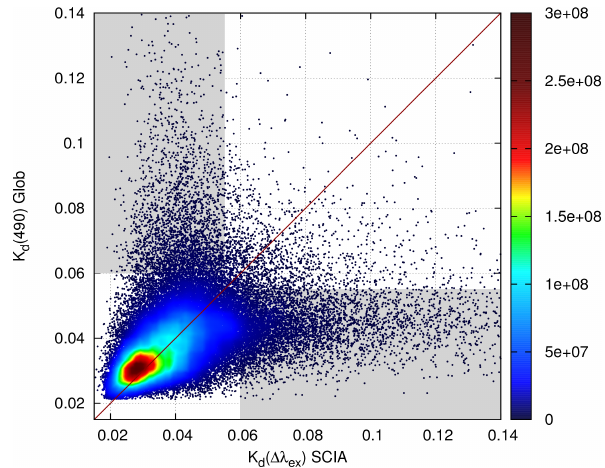
Figure 15. Density map of the scatter plot of K d ((cid:49)λ ex ) retrieved from SCIAMACHY data and the K d ( 490 ) GlobColour data prod- uct, matched by daily grids with a spatial resolution of one